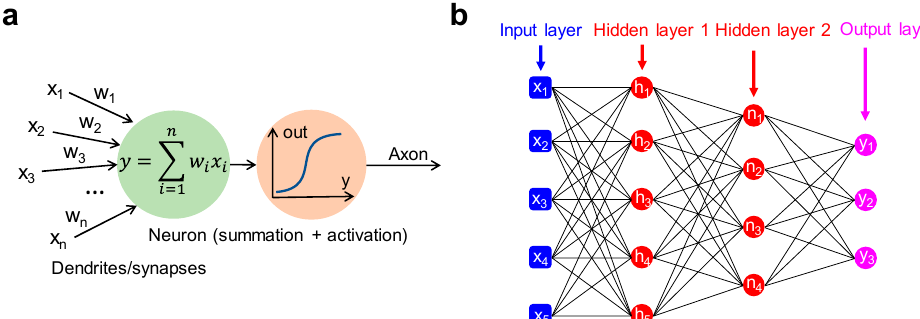
Figure 1. ( a ) Conceptual illustration of McCulloch and Pitts artificial neuron architecture, where the weighted sum of the input signals is subject to the application of a non-linear activation function yielding the output signal. ( b ) Schematic representation of a multilayer perceptron consisting of two hidden layers between the input and the output layer.